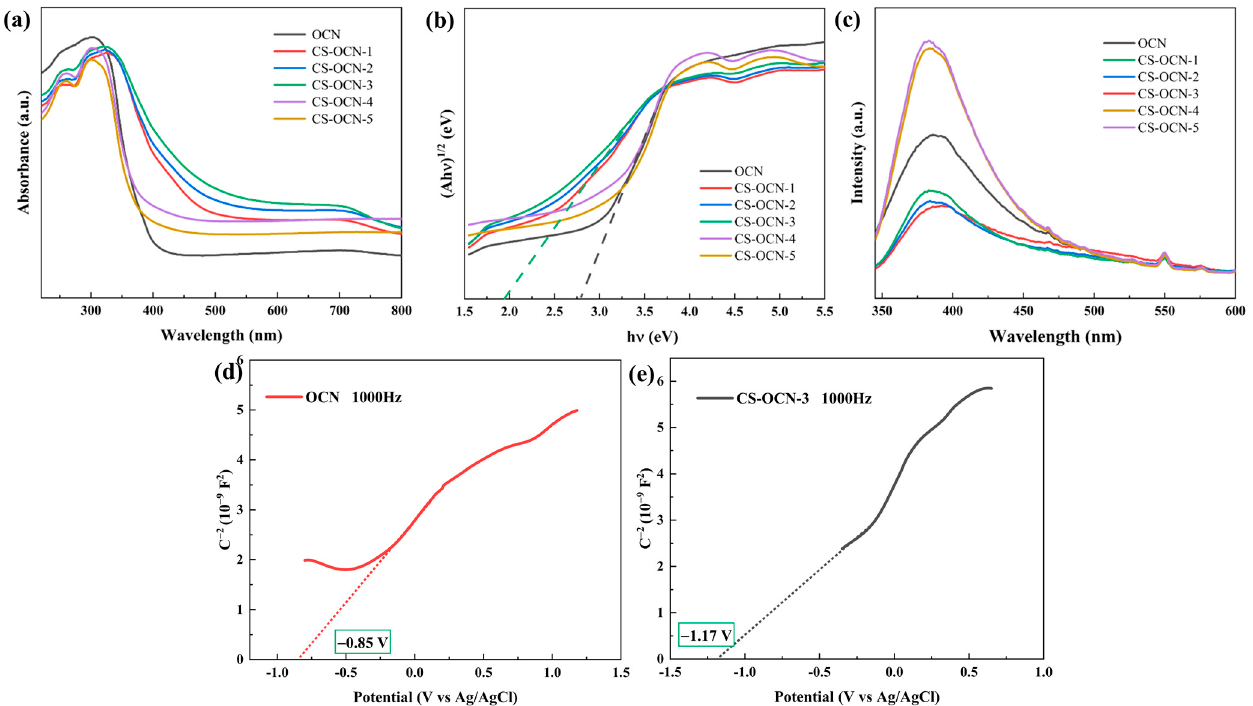
Figure 4. ( a ) UV-Vis light response, ( b ) Band gap energy, ( c ) PL spectra of OCN and CS-OCN, and Mott–Schottky plots of ( d ) OCN and ( e ) CS-OCN-3.